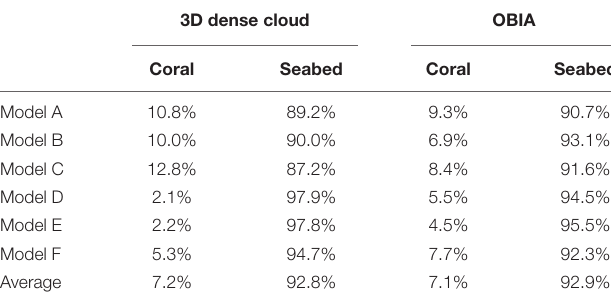
TABLE 2 | Percentage of class distribution results from the manual annotation for each habitat and each class in 2D and